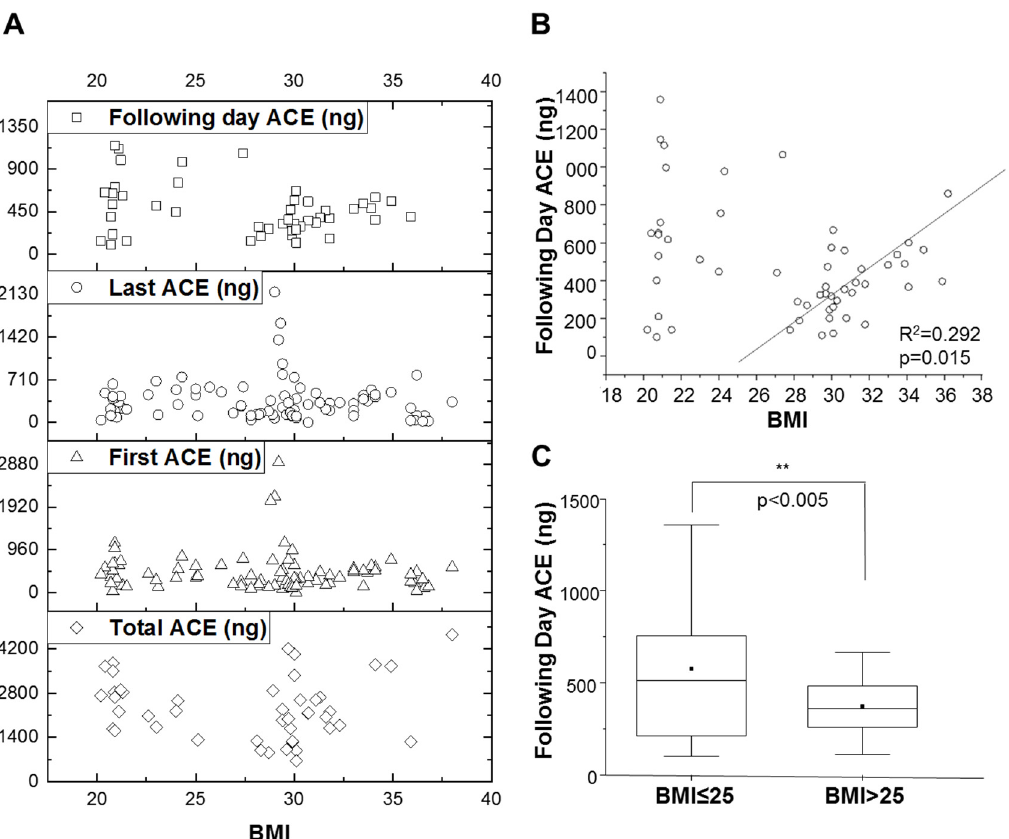
Figure 3. Effects of BMI on ace levels. (A)Spread of ACE values in comparison to BMI; (B) Trend